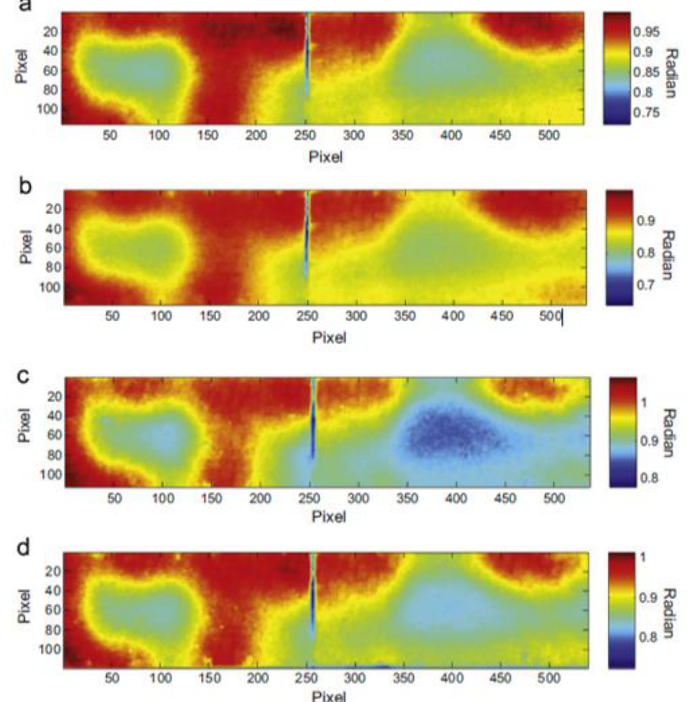
Figure 5. PPT phase results on a single lap joints with CFRP adherends undergone to different fatigue loading cycles, with permission from [57]. Each subfigure corresponds to the thermal phase image of the composite sample after 200 cycles ( a ); 400 cycles ( b ); 400 cycles and pretension ( c ) and 600 cycles ( d ).